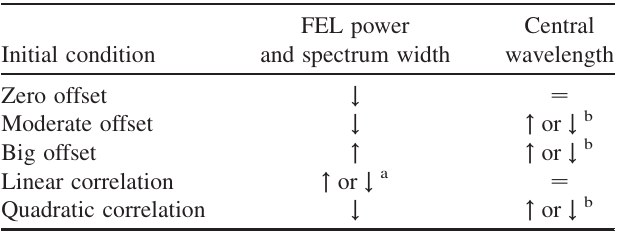
TABLE II. Dispersion impact on the wavelength spectrum for different initial transverse